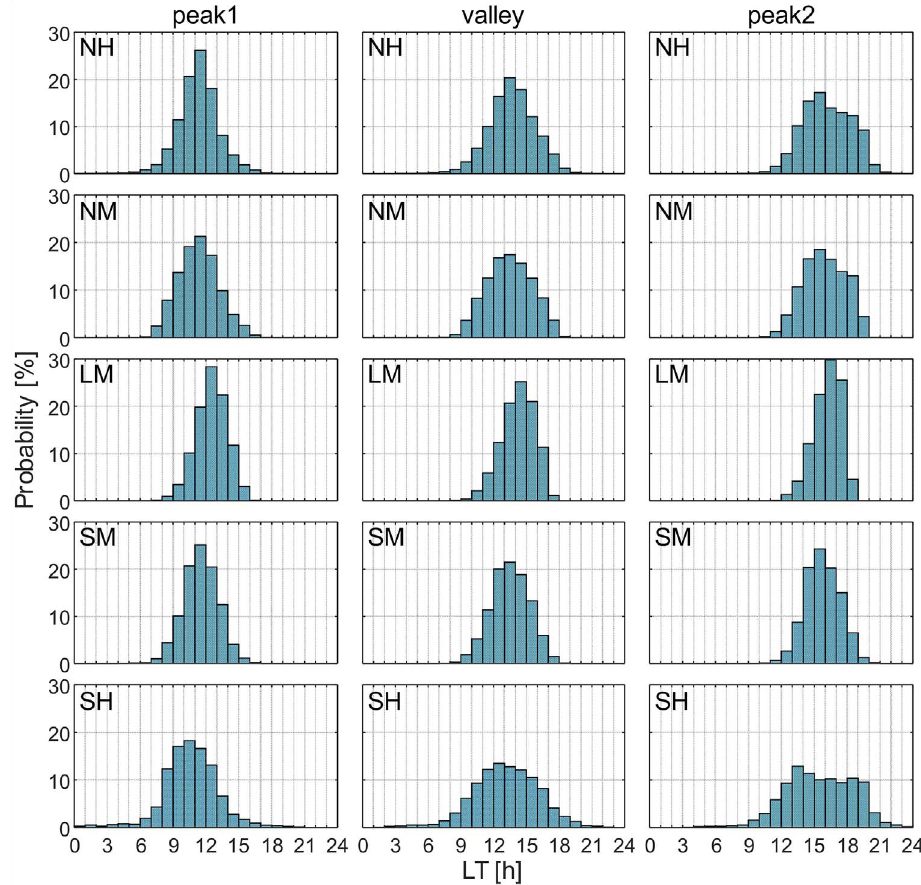
Figure 9. The histogram of the occurrence time of the ionospheric DDM structures in each MLAT